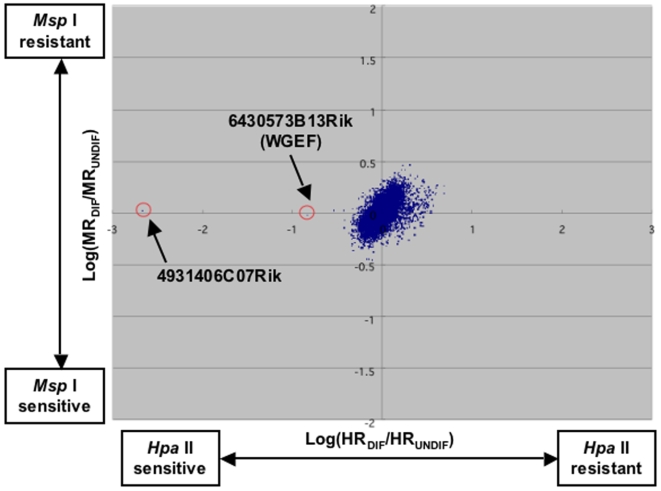
Application of the MIAMI method to 3T3-L1 cells.We applied the MIAMI method to 3T3-L1 cells that were differentiated (DIF) and undifferentiated (UNDIF). We defined resistance as reciprocal sensitivity. Therefore, Hpa II-sensitive (cleavable) DNA and Msp I-sensitive (cleavable) DNA were amplified and used to calculate Hpa II resistance (HR) and Msp I resistance (MR), respectively. Values of log (HRDIF/HRUNDIF) are plotted on the x-axis and log (MRDIF/MRUNDIF) are plotted on the y-axis. Two genes indicated by arrows are clearly hypomethylated after differentiation.